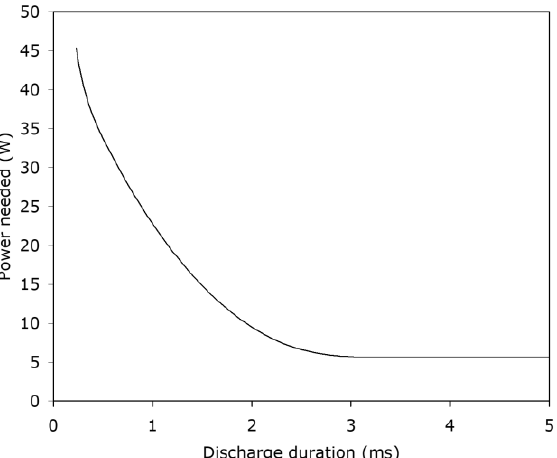
Figure 8. Minimum power needed to ignite an 8.3% methane/air mixture using the IEC 60079-11 apparatus (27 VDC power supply, resistive circuit, spark at a tungsten wire separating from a cadmium plate).